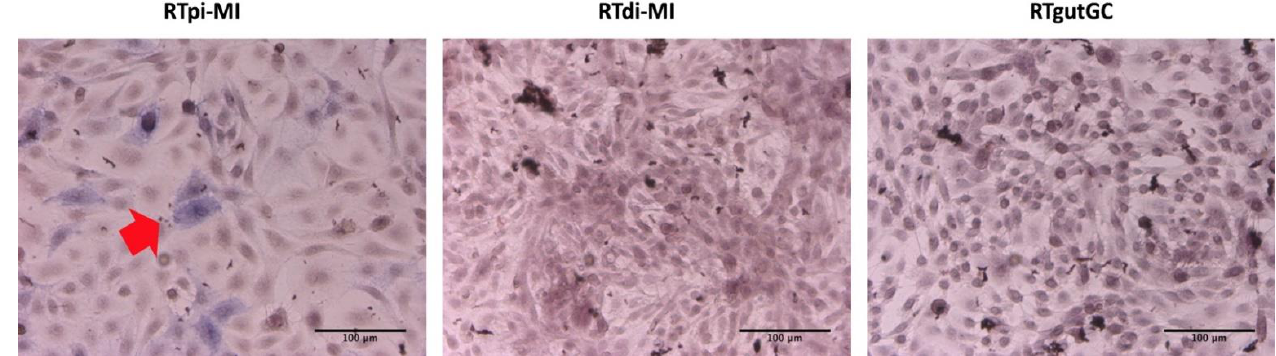
Figure 7. Alkaline phosphatase activity was only found in RTpi-MI at high seeding density (blue color, indicated by red arrows). Hematoxylin was used to stain the cell nucleus. Scale bar, 100 µm.